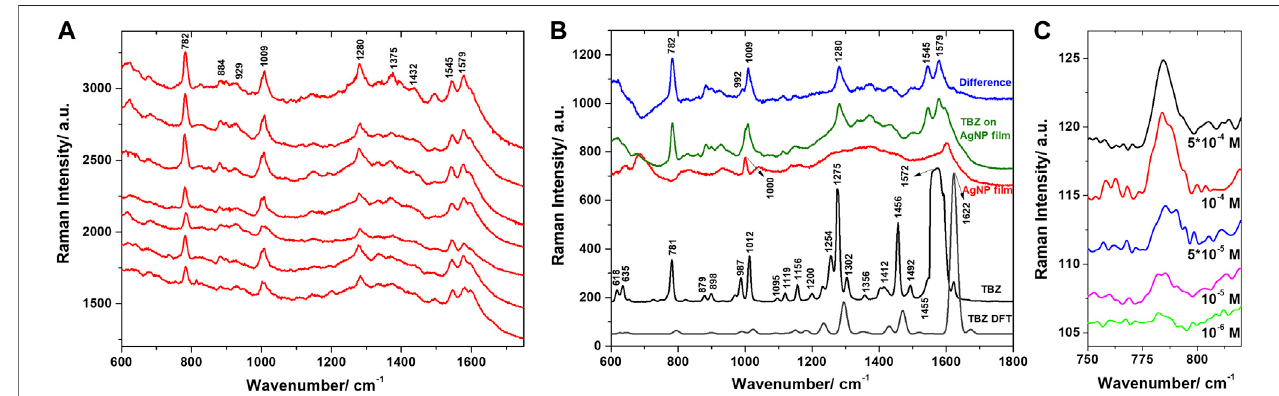
FIGURE6|(A) SERSspectraofTBZonAgNPs fi lmcollectedfromvariouslocationsonthesubstrate.Excitation785 nm. (B) TheRamanspectrumofTBZpowder and the DFT calculated Raman spectrum compared to the average Raman spectrum of the bare AgNPs fi lm, the average SERS spectrum of TBZ on the fi lm, and their computed difference spectrum. (C) SERS spectra of TBZ on AgNPs fi lm for various TBZ